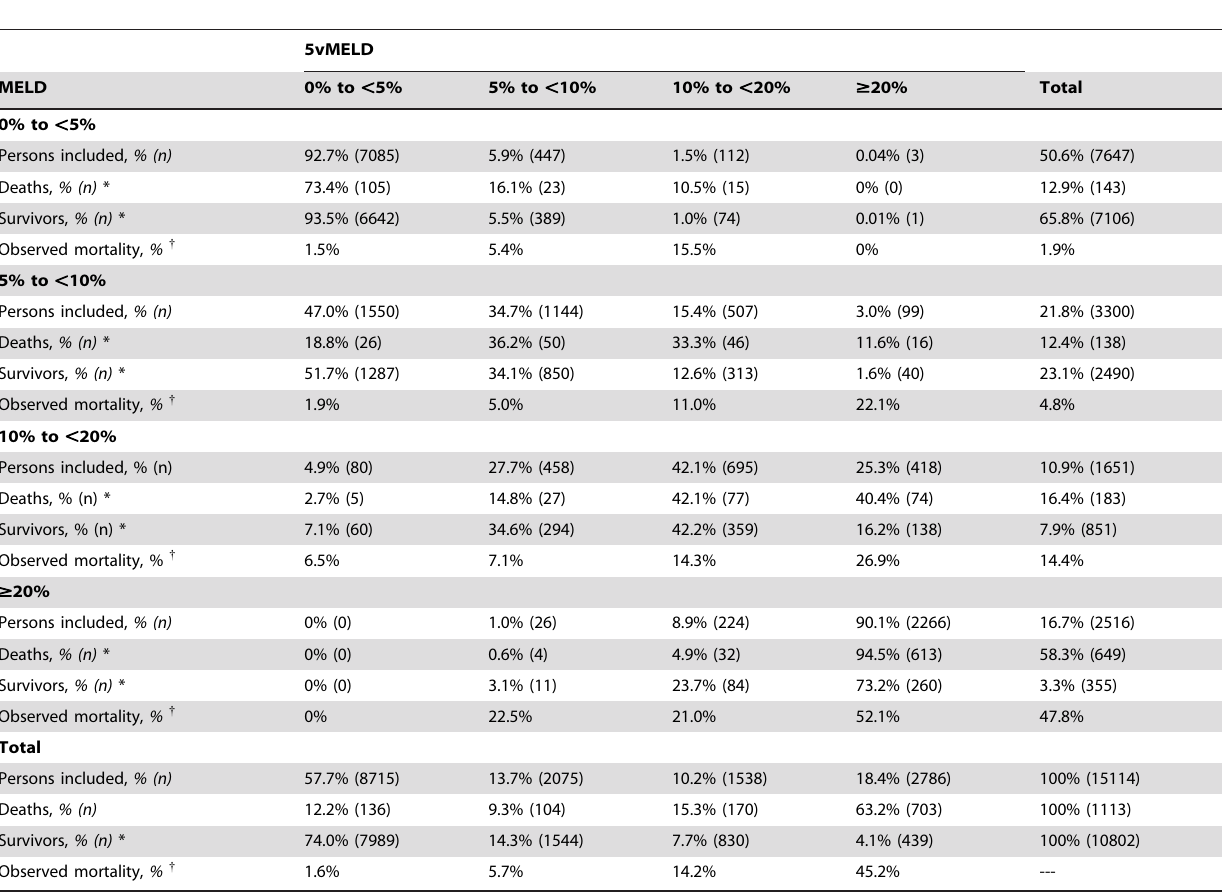
Table 3. Risk Reclassification Table Comparing 90-Day Mortality Risk Strata According to MELD and 5vMELD